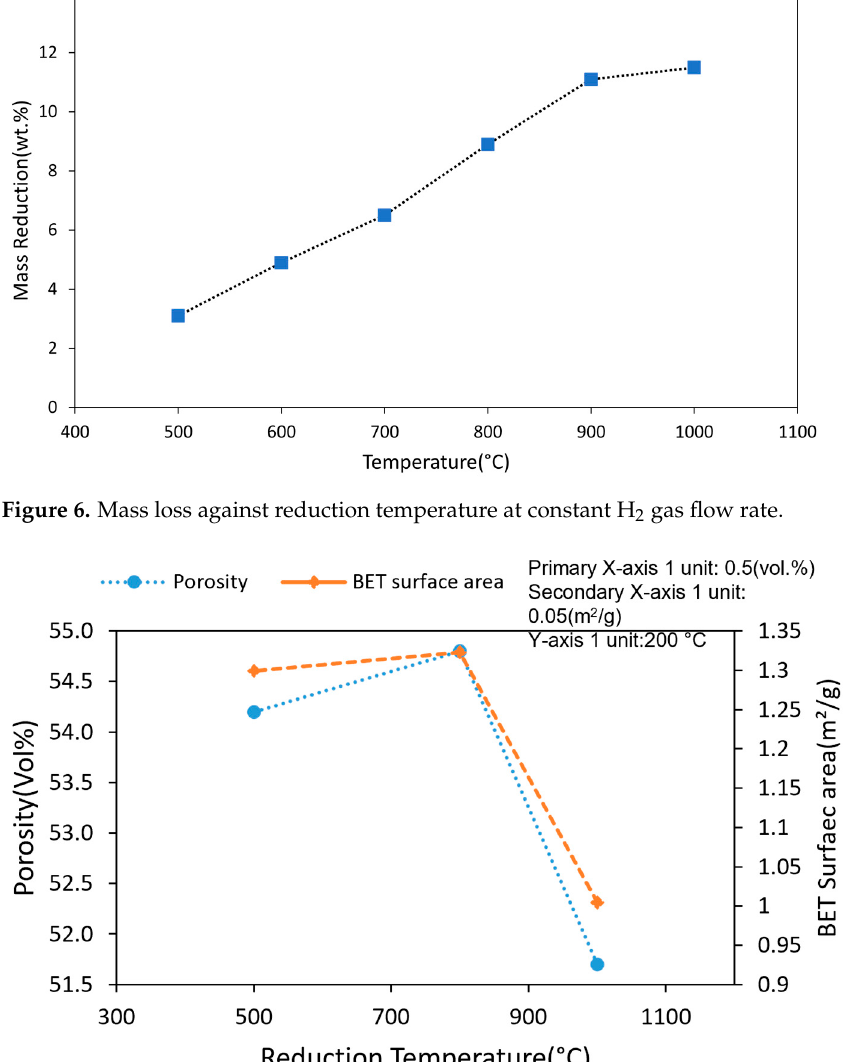
Figure 6. Mass loss against reduction temperature at constant H 2 gas flow rate.